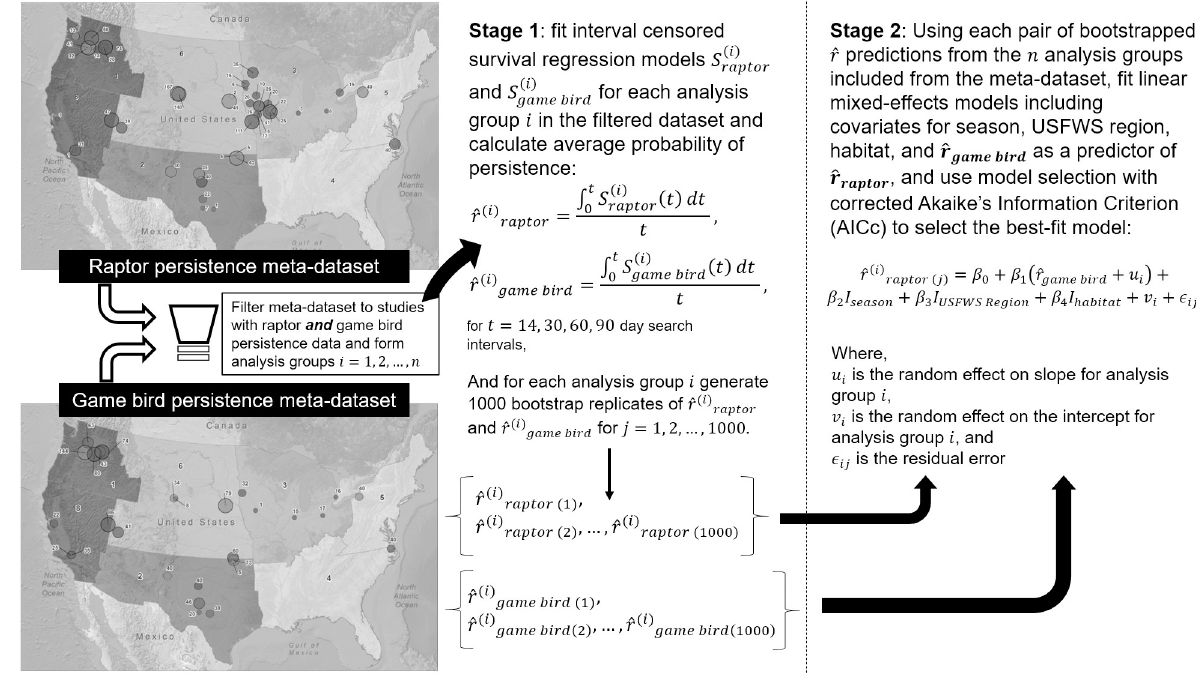
Fig 3. The 2-stage analysis process to develop a model for scaling persistence probabilities ( b r ) from game birds to raptors using a meta-dataset curated from studies in the United States.